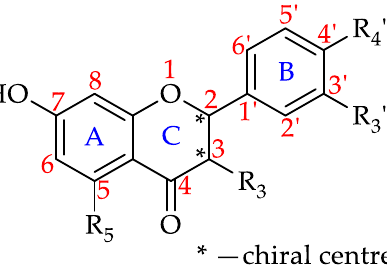
Figure 10. Basic flavononol structure (see 66 – 72 in Table 5). Table 5. Flavanonols reported in monofloral honeys (see Figure 10 for general structure).